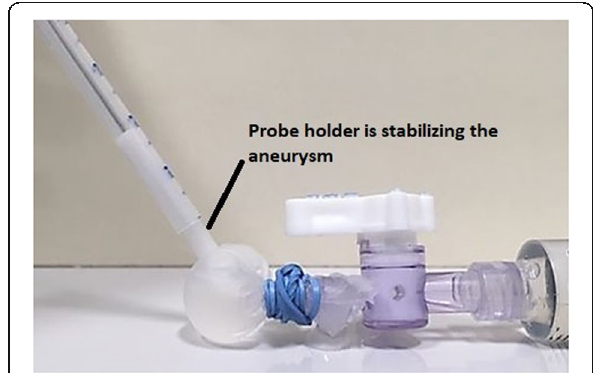
Fig. 3 A free-hand aneurysm coiling procedure. The probe holder has stabilized the